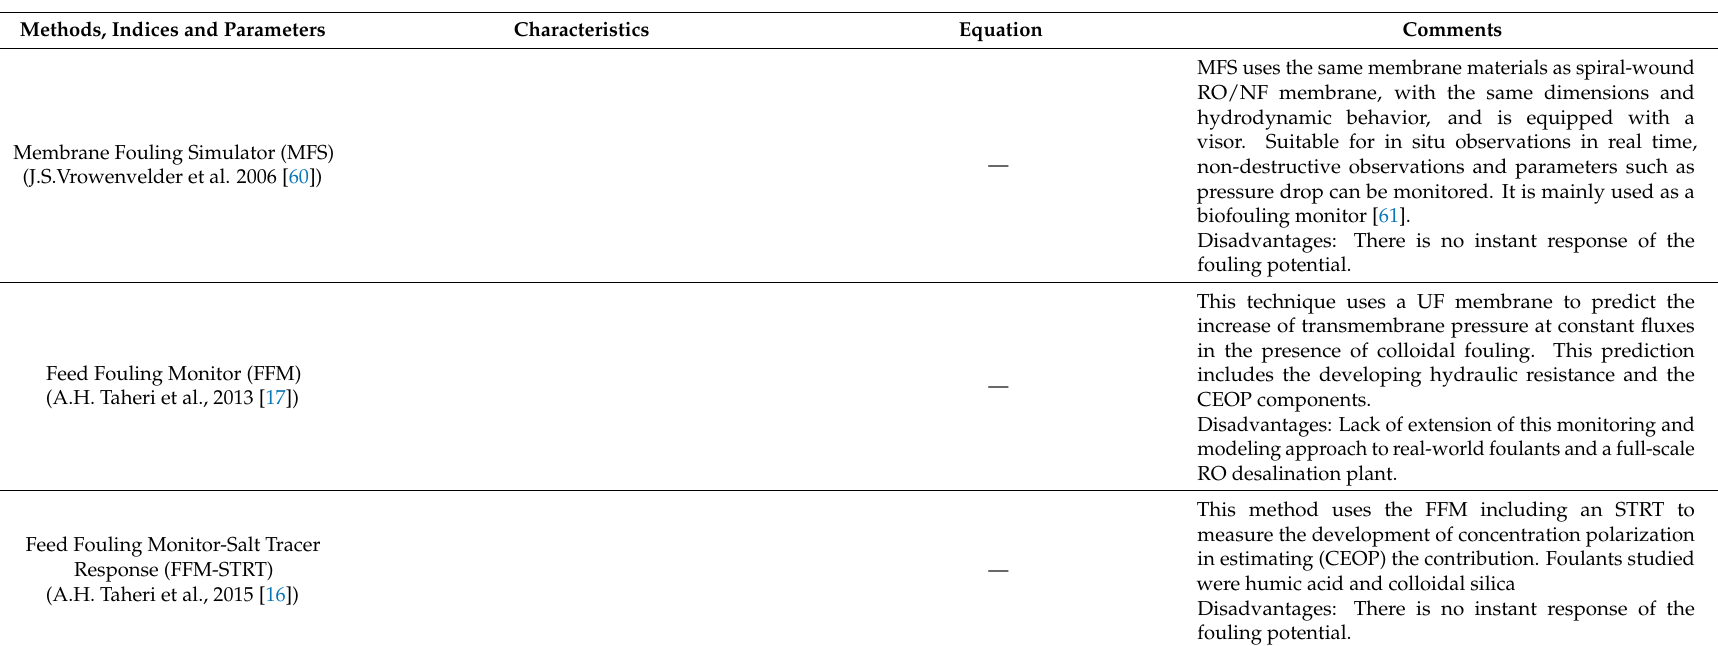
Methods, Indices and Parameters